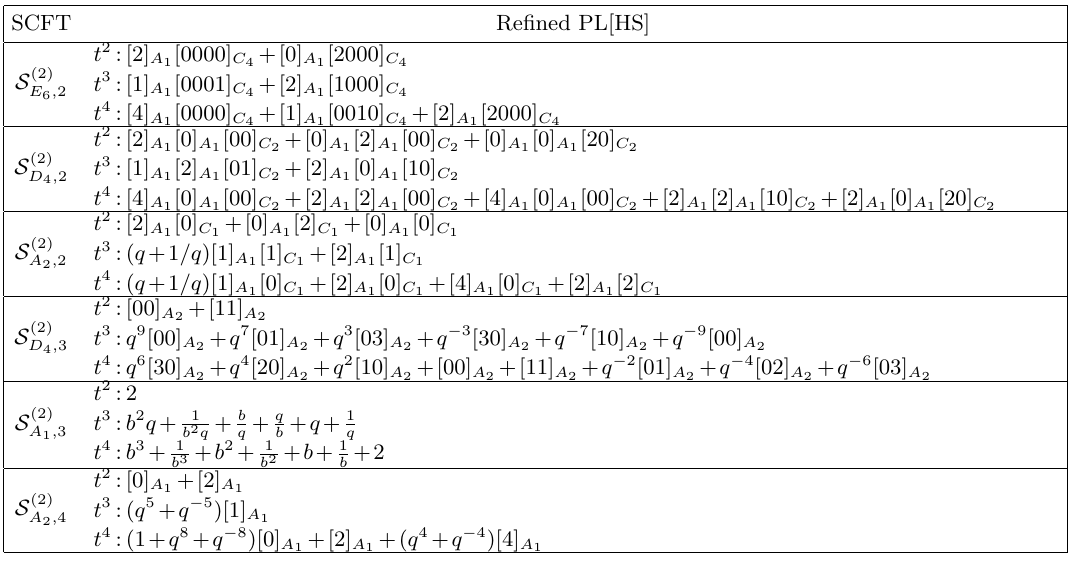
Table 4. Refined plethystic logarithm of the Hilbert series for the magnetic quivers of the S ( r =2) theories in table 1. In abuse of notation, [ . . . ] Dynkin labels [ . . . ] . Moreover, q and b label U(1)